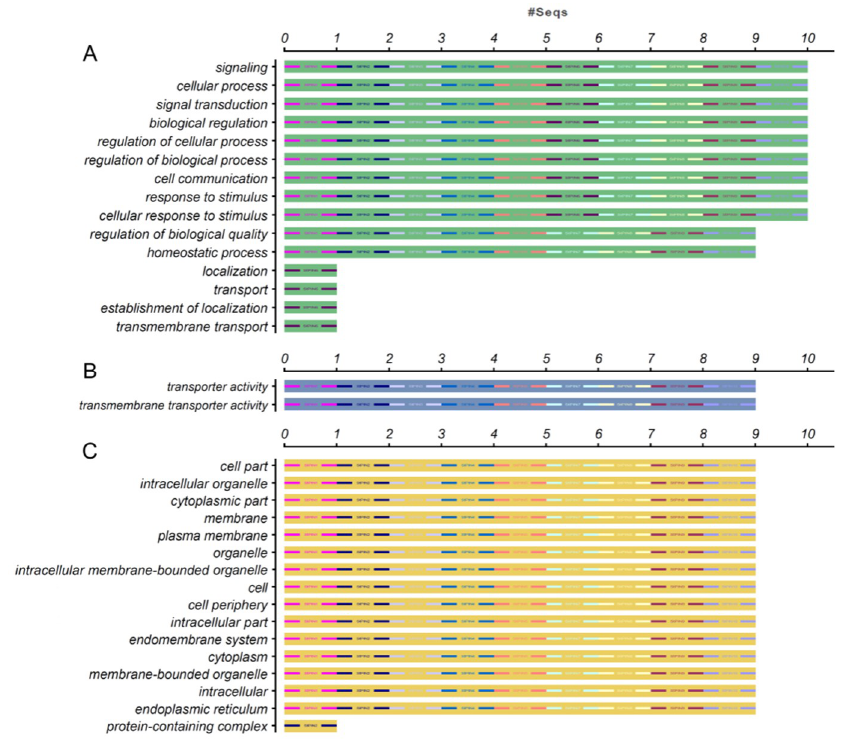
Figure 4. Gene ontology (GO) annotation of StPIN proteins. The gene ontology (GO) analysis of potato PIN proteins were performed using the Blast2GO software (https://www.blast2go.com/). The full-length amino acid sequences of 10 StPIN proteins were uploaded to the program with the NCBI database chosen as the reference. The annotation was performed on three categories, ( A ) biological process, ( B ) molecular function and ( C ) cellular component. The numbers on the abscissa indicate the number of predicted proteins.